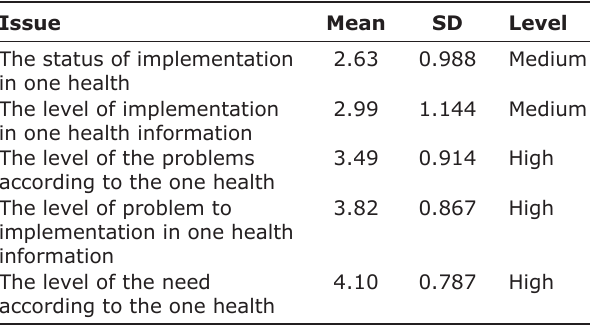
Table-2: The level of attitudes about the comments on each issue (n=400). Issue Mean SD